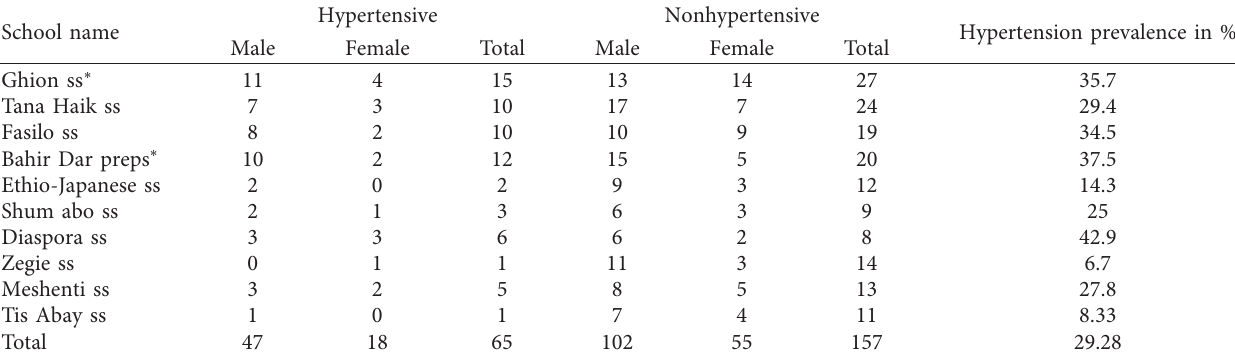
Table 3: Prevalence of hypertension in the study